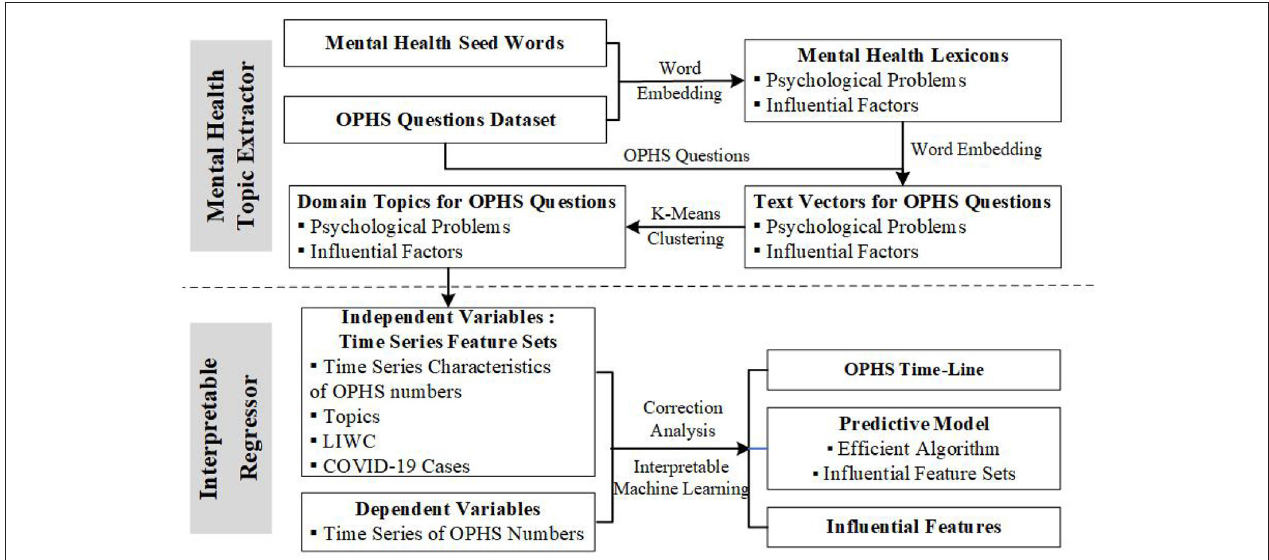
FIGURE 1 | Research methods and